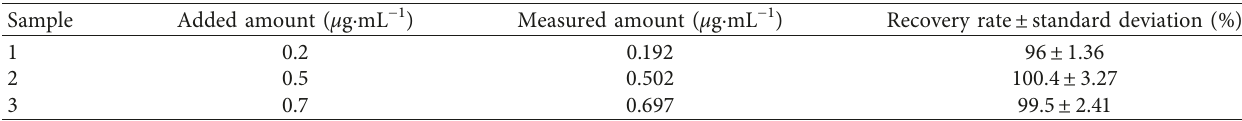
Table 2: Sample testing ( n � 10).